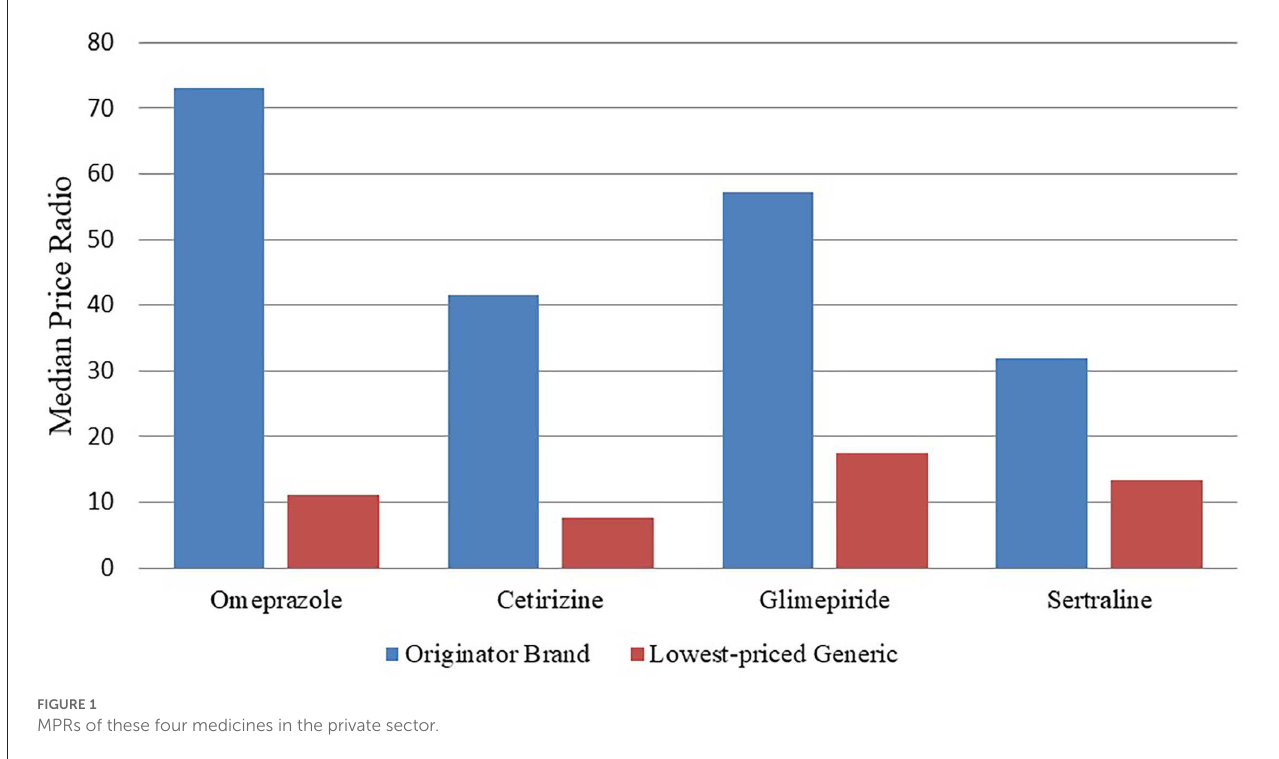
FIGURE1 MPRs of these four medicines in the private sector.